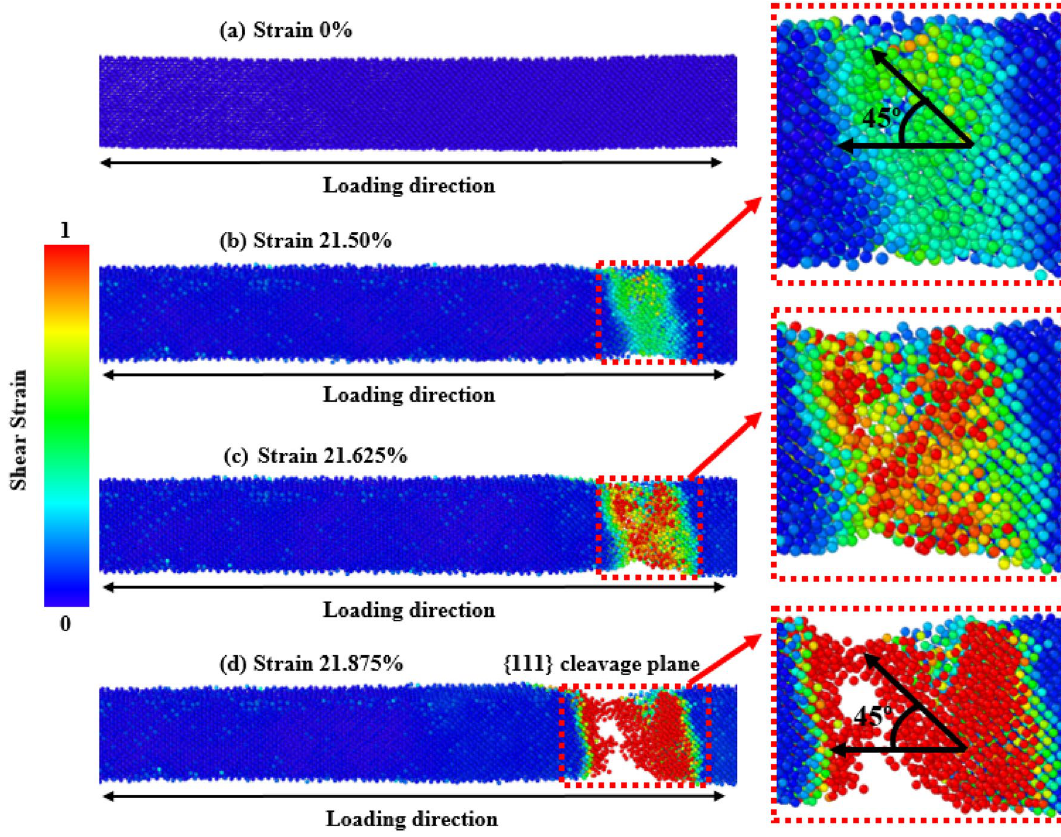
Figure 8. Tensile deformation profiles of [100] directed 15.76 nm 2 zinc-blende ZnSe NWs for various strain levels at 300 K. The zoomed-in view shows the dislocation slipping induced {111} cleavage plane along an angle of 45° with the applied